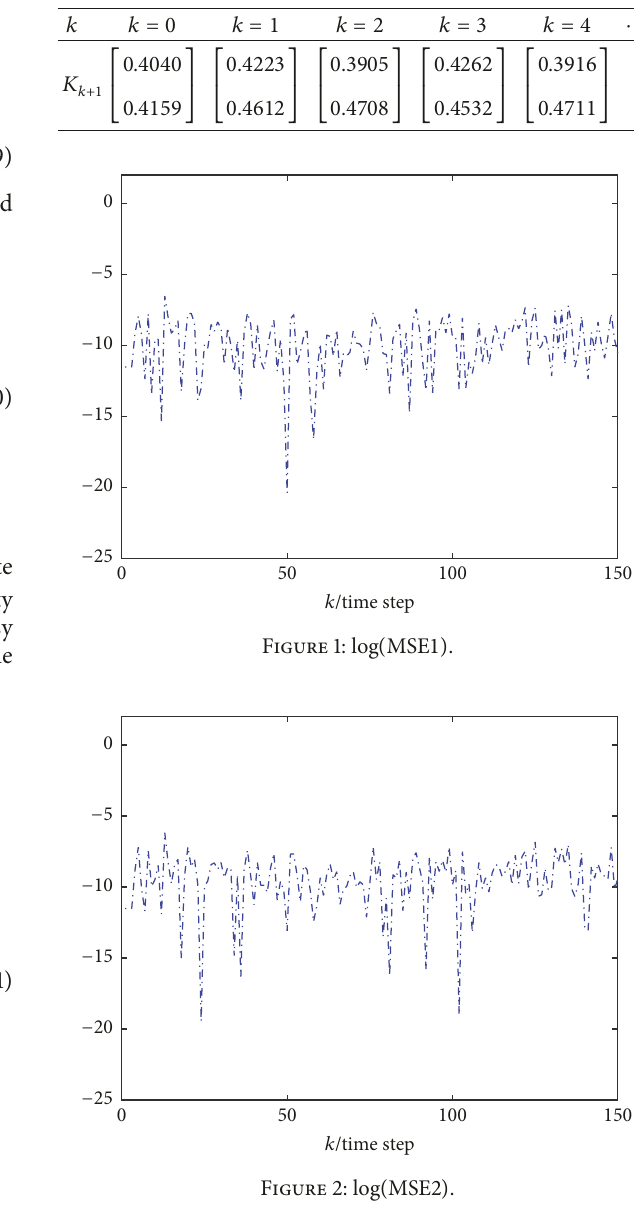
Table 1: Filter gain matrices 𝐾 𝑘+1